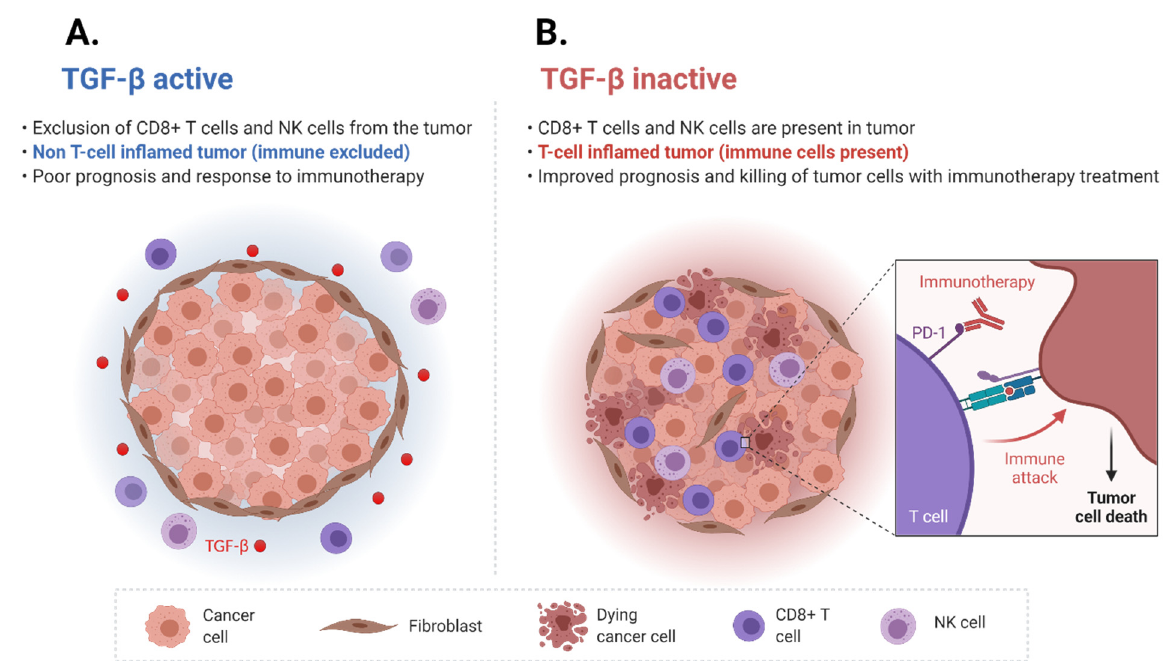
Figure 3. TGF- β signaling pathway drives immune cell exclusion. ( A ) Active TGF- β signaling pathway drives immune cell exclusion. ( B ) Inactive TGF- β signaling pathway drives a T cell-inflamed tumor phenotype (adapted from “Cold vs. Hot tumors”, by BioRender.com (2021). Retrieved from https://app.biorender.com/biorender-templates, accessed on 14 October 2021.